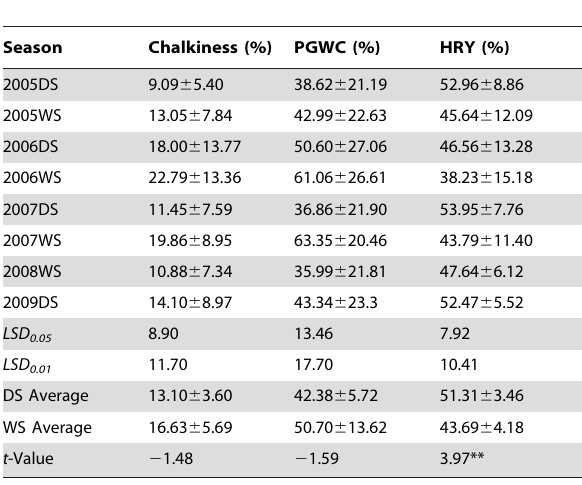
**represents significant at P , 0.01.